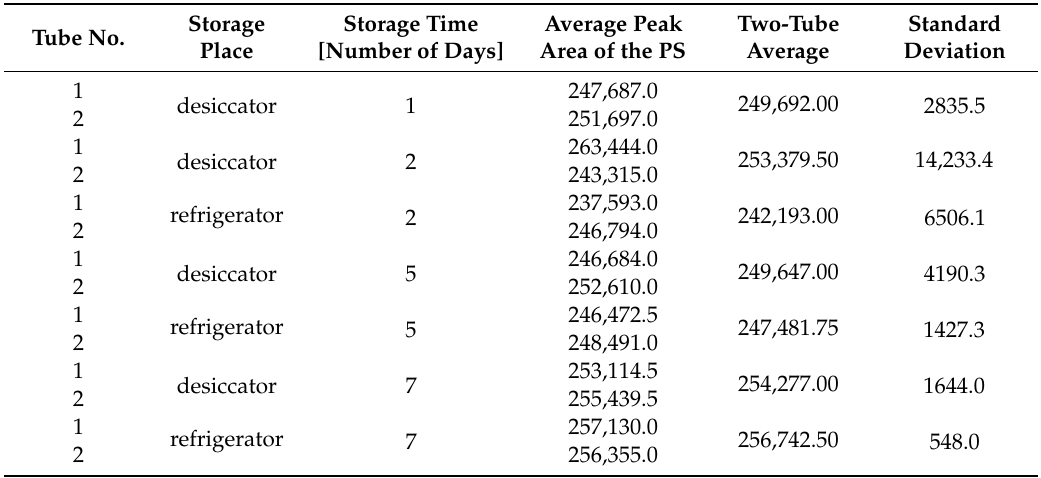
Table 4. Results of the stability test of samples containing about 5 µ g PS. GC-MS, HP-5MS column, programmable column temperature.